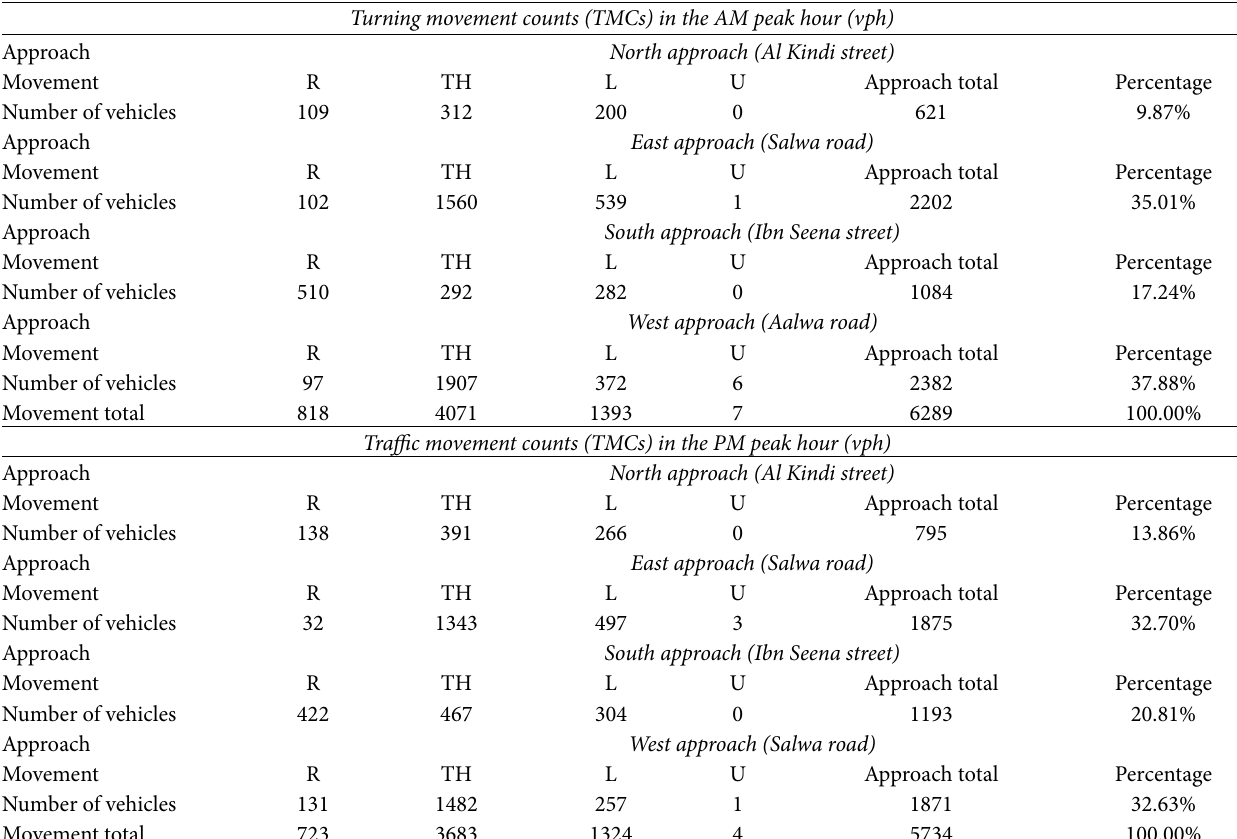
Table 2: Turning movement counts (TMCs) during peak hours.